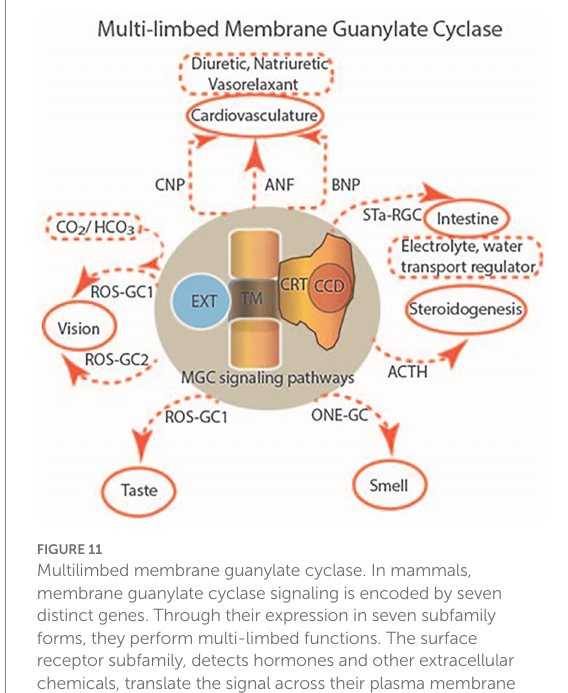
FIGURE 11 Multilimbed membrane guanylate cyclase. In mammals, membrane guanylate cyclase signaling is encoded by seven distinct genes. Through their expression in seven subfamily forms, they perform multi-limbed functions. The surface receptor subfamily, detects hormones and other extracellular chemicals, translate the signal across their plasma membrane domains and by way of their second messenger, cyclic GMP, regulate an intracellular pathway to impact physiology. Sequentially, other similar signaling networks, depicted in the figure, were discovered. Collectively, besides steroidogenesis, they control the physiology of the cardiovasculature, sensory neurons: vision, taste and smell, the intestine and skeletal growth. Uniquely designed, all forms are single-pass transmembrane proteins, embedded with an EXT, TM, CRM and CCD topography. Abbreviations: EXT, extracellular; TM, transmembrane; CRM, catalytic regulatory module; CCD, catalytic core domain.